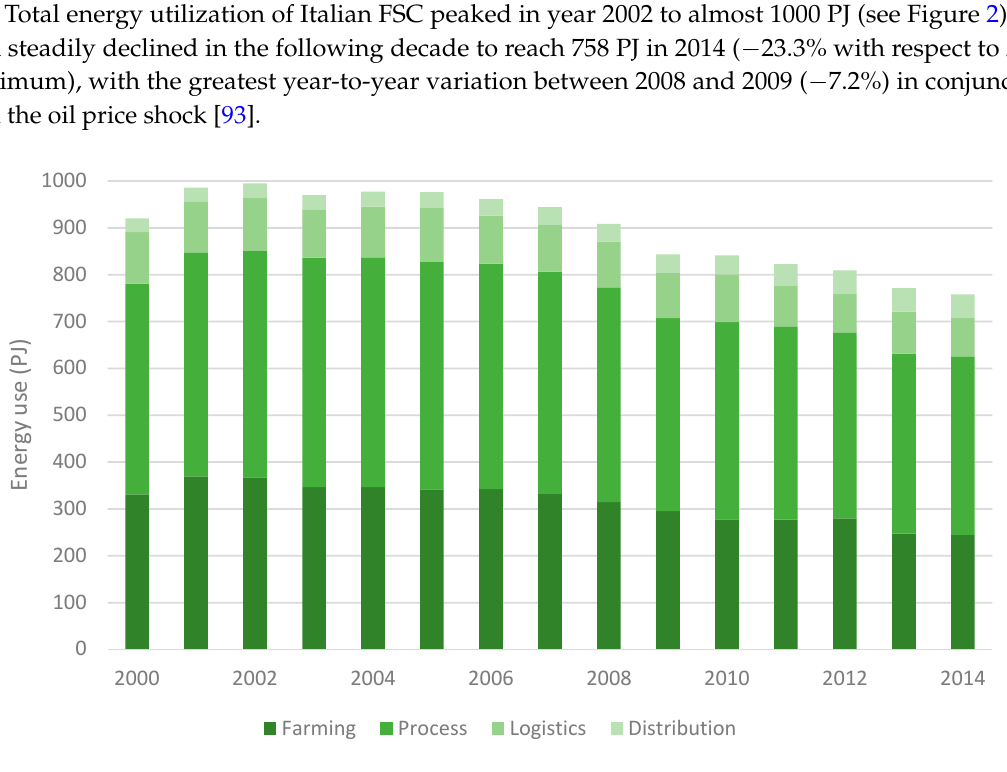
Figure 2. Total Energy use in the Italian food chain, 2000–2014.